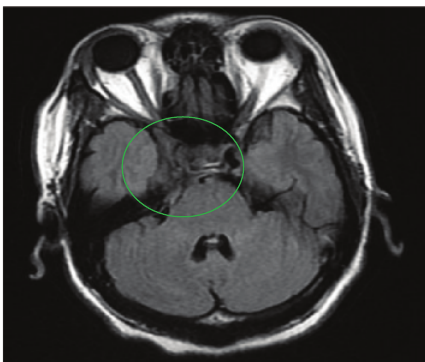
Figure 1: Initial cranial MRI revealing abnormal enhancement involving the right cavernous sinus area extending along the tracks of the right fifth, seventh, and eighth cranial nerves.